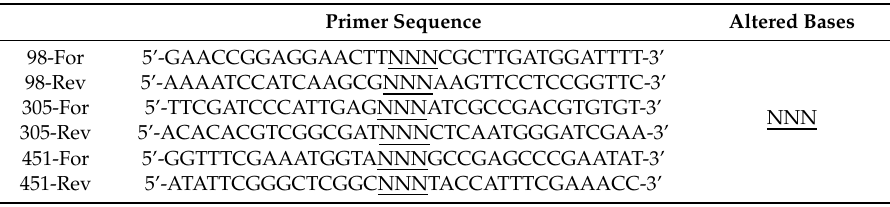
Table 4. Primer sequence for site-directed saturation